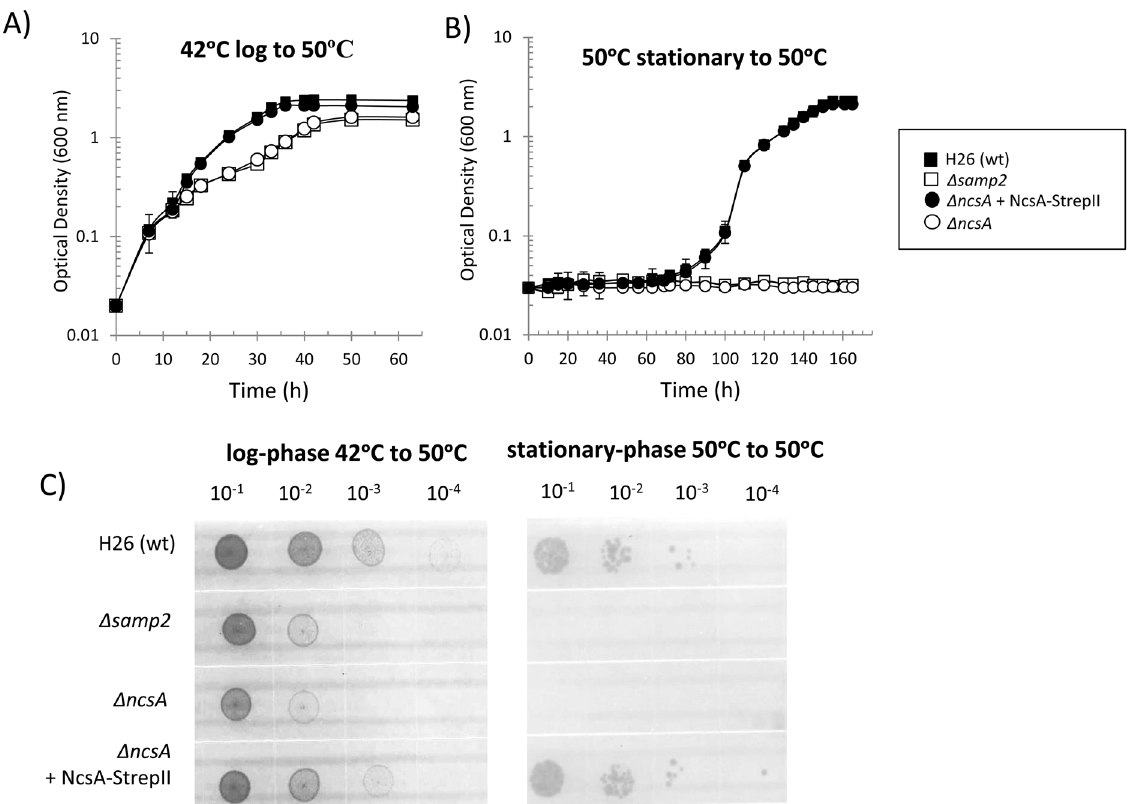
Figure 3. NcsA is required for growth of Hfx.volcanii at an elevated temperature (50 6 C). Hfx. volcanii H26 (wt, parent), D samp2 , D ncsA , and trans complemented D ncsA strains were grown in ATCC 974 medium. Freshly isolated colonies were inoculated into 3 ml medium (in 13 6 100 mm culture tubes) and thrice subcultured at 42 u C. Cells grown to logarithmic phase at 42 u C from these subcultures were used as inoculum for monitoring growth at 50 u C as presented in panel A. Cells grown to stationary-phase from these 50 u C cultures were used as an inoculum for monitoring long-term growth at 50 u C as presented in panel B. Inoculum was at 0.02 OD 600 with rotary shaking (200 rpm) in 20 ml medium in 250 ml baffled flasks for the growth assays presented in panels A and B. For panel C, cell cultures, as indicated above each plate, were diluted to 0.1 OD 600 and then spot-plated on solid agar ATCC 974 medium in serial dilutions as indicated. Plates were incubated at 50 u C. Control experiments performed at 42 u C are presented in Figure S4 in File S1. See Methods section for details.